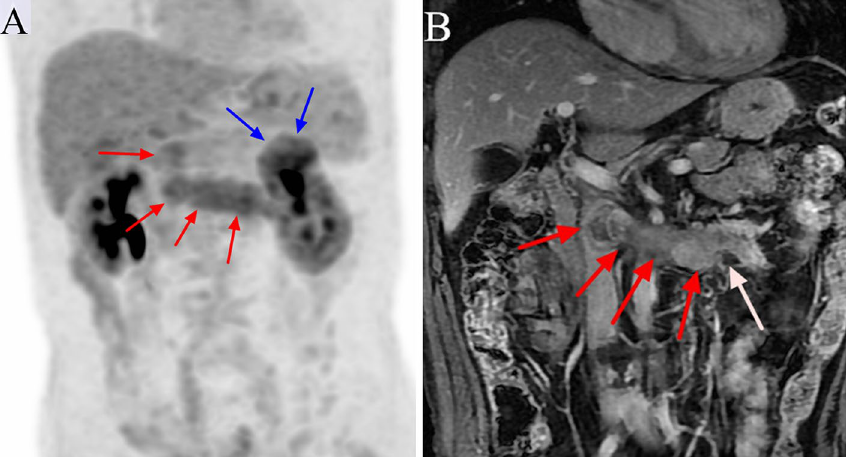
Figure 2. 18 F-FDG PET/CT and contrast-enhanced MRI (CEMRI) scans of a 75-year-old man with clear cell carcinoma of the left kidney associated with a level II venous tumour thrombus (VTT) and small venous bland thrombus (VBT). The VTT did not invade the venous wall and was graded as level II by PET/CT and CEMRI. The site of focally increased FDG uptake (SUVmax 5.8) on the PET maximum intensity projection image is the primary tumour (blue arrow) ( a ). A PET maximum intensity projection image ( a ) shows a site of pathologically increased FDG uptake (SUVmax 4.4) from the left renal vein to the inferior vena cava that is the VTT (red arrow). The VTT has a regular shape, is homogeneously enhanced, and completely occludes the inferior vena cava lumen on coronal CEMRI (red arrow) ( b ). The small VBT shows no enhancement on coronal CEMRI (white arrow) ( b ).